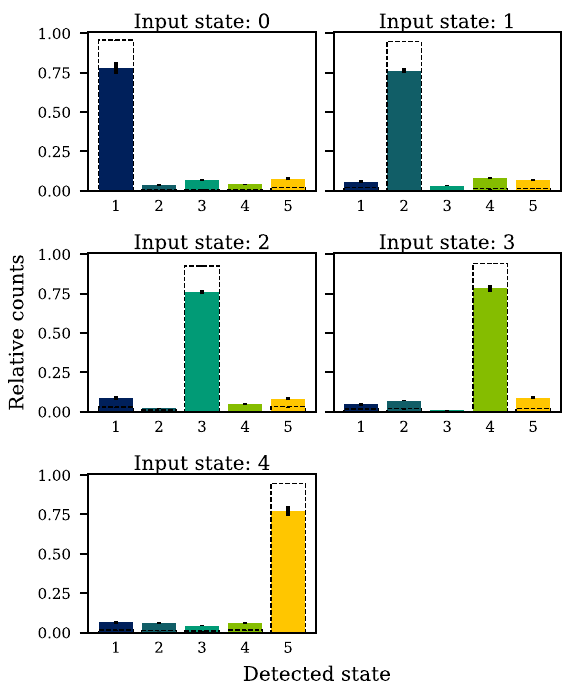
FIG. 6. Relative counts obtained when we project the five ele- ments of one MUB onto the same MUB with the complete decoder (filled bars) and internal performance of the MQPG (dashed lines). The error bars represent the error on the mean relative counts of 30 data